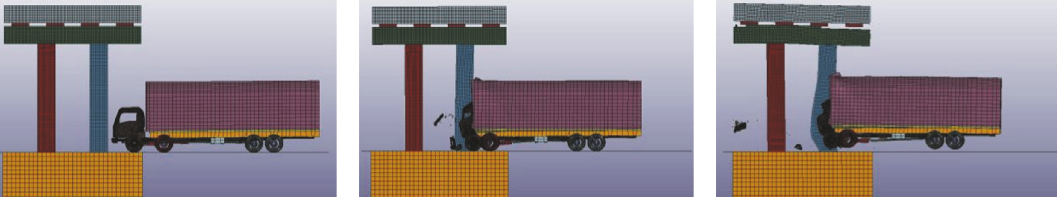
Figure 15: Process of vehicle-pier collision.